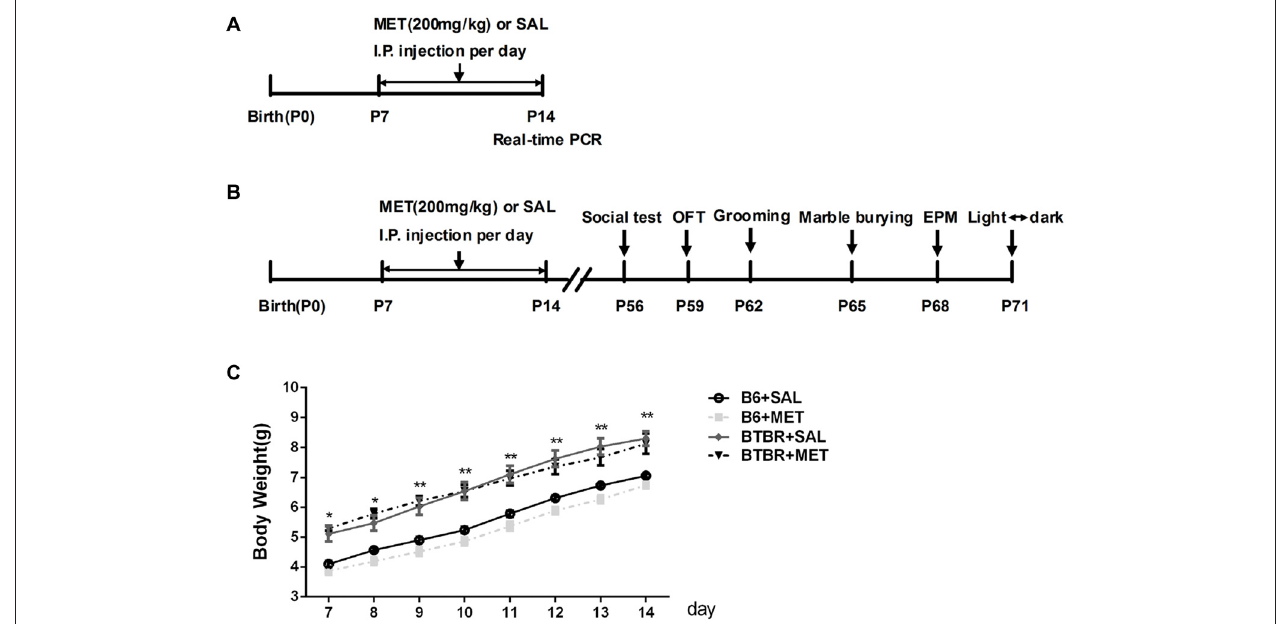
FIGURE 1 | Schematic diagram of the experimental procedures. (A) Neonatal male mice (B6 or BTBR) were injected with metformin (MET; 200 mg/kg) or saline (SAL) from P7 to P14 once per day. (B) The behavior tests were conducted at the age of 8 weeks. (C) The effects of MET on the average body weight of mouse pups. OFT, Open Field Test; EPM, Elevated Plus-Maze. ∗ p < 0.05, ∗∗ p <